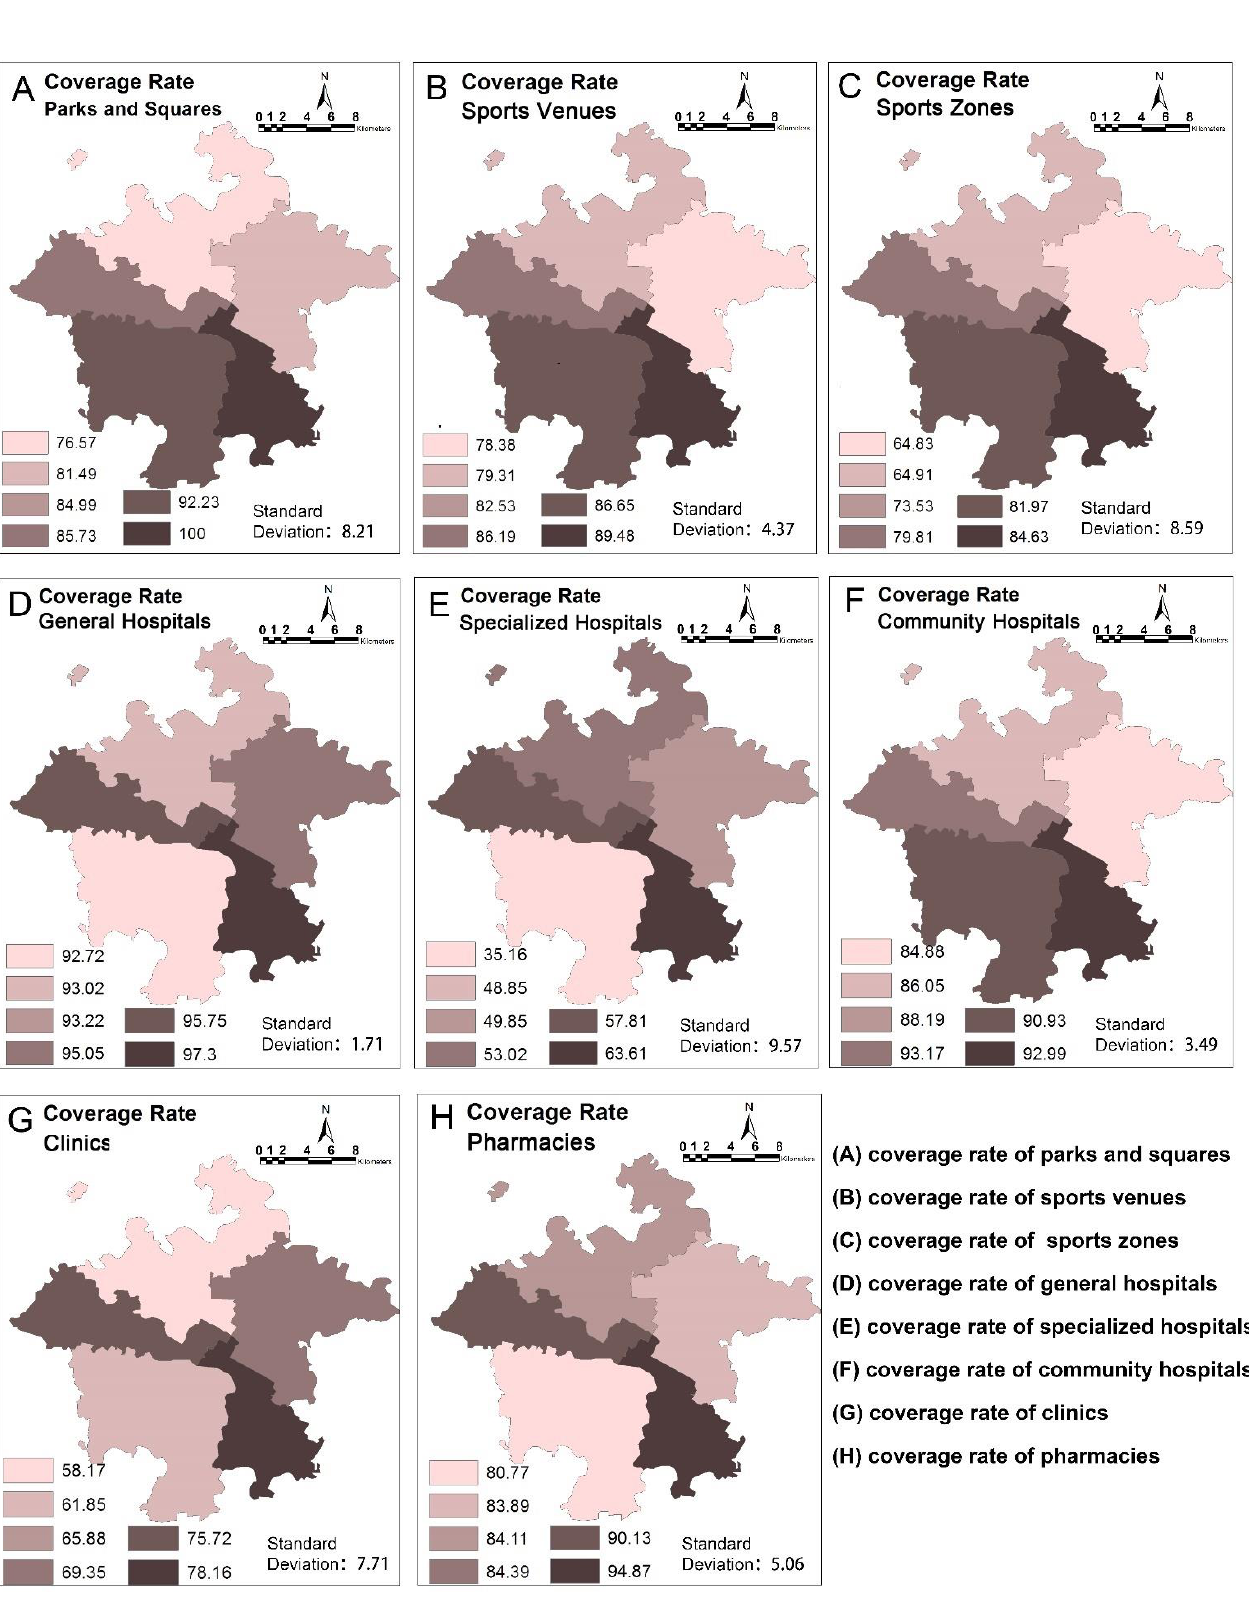
Figure 3. Coverage rates of health facilities within the 15 min community-life circles in the main urban area of Chengdu.